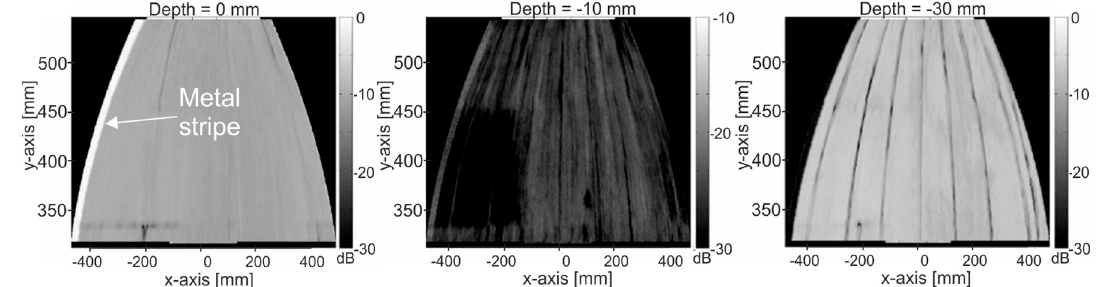
Figure 8. Terahertz images of the radome structure at three distinct depth layers reconstructed from the measurement data of the 100 GHz sensor unit. The left image shows the radome’s smooth surface, while the center image shows the radomes inner structure at a depth of 10 mm below the surface. The right image of the radome’s back surface reveals individual GFRP panels aligned with its longitudinal axis.